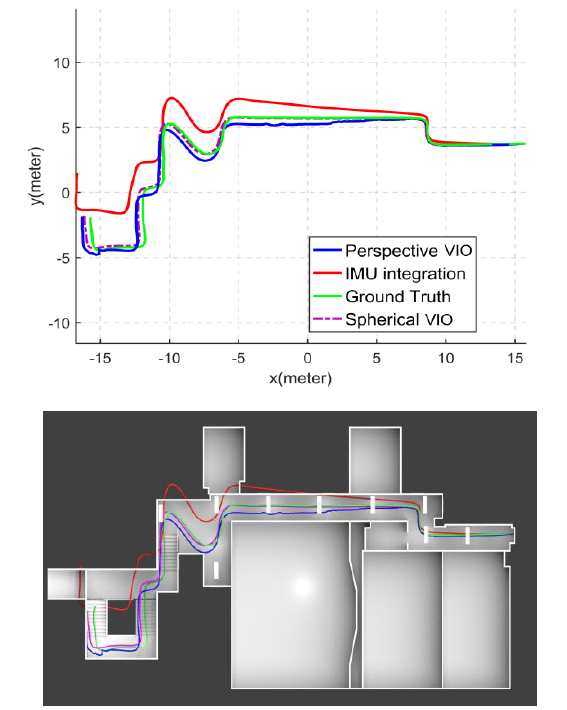
Figure 8. Top view of the estimated trajectory for perspective VIO (blue), and spherical VIO (magenta) compared with the IMU only integration (red) and the ground truth (green).